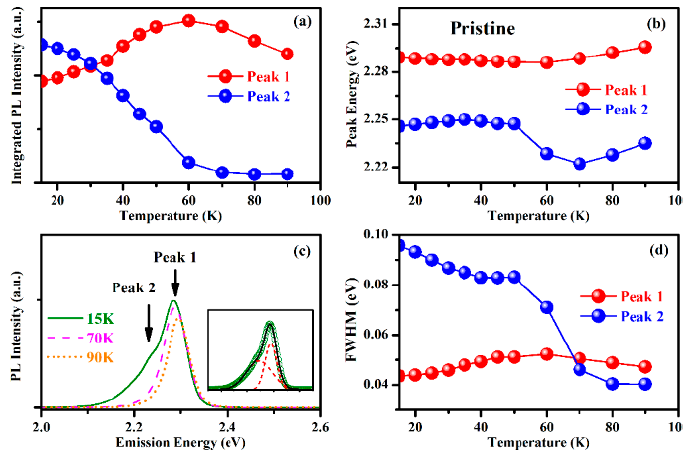
Figure 6. The comparison of two Gaussian fitted peaks from PL spectra of pristine MBNCs-PVDF: ( a ) Integrated PL intensity; ( b ) PL emission peak energy; and ( d ) FWHM of the fitted peaks obtained by two-peak Gaussian fitting. ( c ) PL spectra at 15 K, 70 K, and 90 K of pristine MBNCs-PVDF, illustrating the evolution of multipeak PL emission at low temperature, with the inset showing the two-peak Gaussian fitting result for the PL spectrum at 15 K.